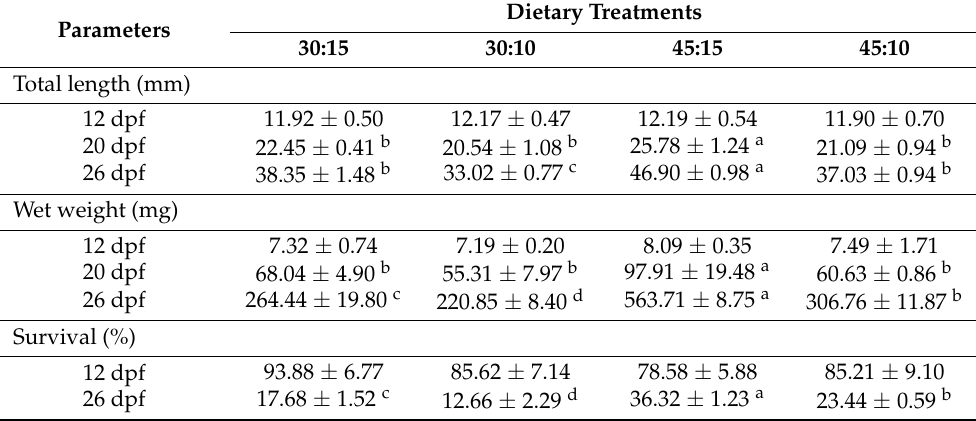
Table 2. Growth in terms of total length and wet weight at 12, 20, and 26 dpf, and survival at the end of the Artemia and compound diet feeding periods (12 and 26 dpf) of P. punctifer reared at 28 ◦ C and in complete darkness. Data are expressed as means ± standard deviation (S.D.) ( n = 45). Different superscript letters indicate statistically significant differences between dietary treatments (one-way ANOVA, p < 0.05). Dietary treatment codes correspond to the protein:lipid level included in the tested